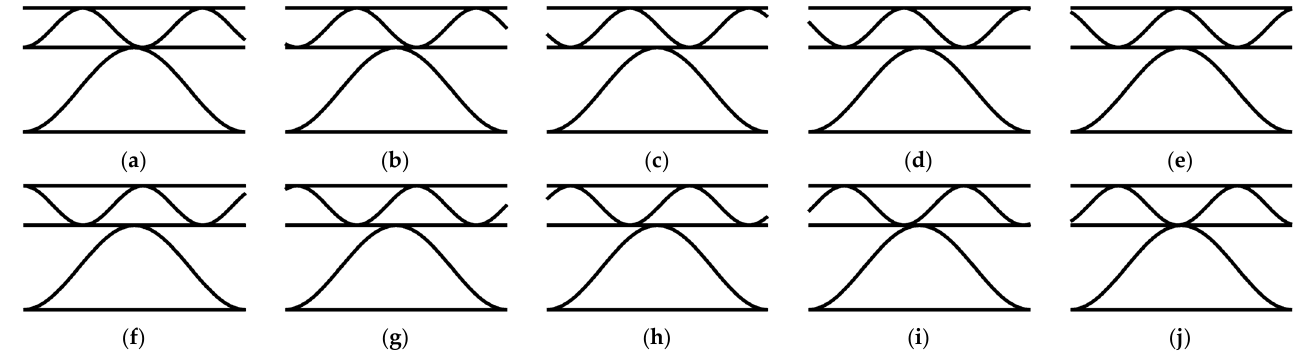
Figure 5. Cross-sections of corrugated board along the wave with offsets of ( a ) 0%, ( b ) 10%, ( c ) 20%, ( d ) 30%, ( e ) 40%, ( f ) 50%, ( g ) 60%, ( h ) 70%, ( i ) 80%, and ( j ) 90%.